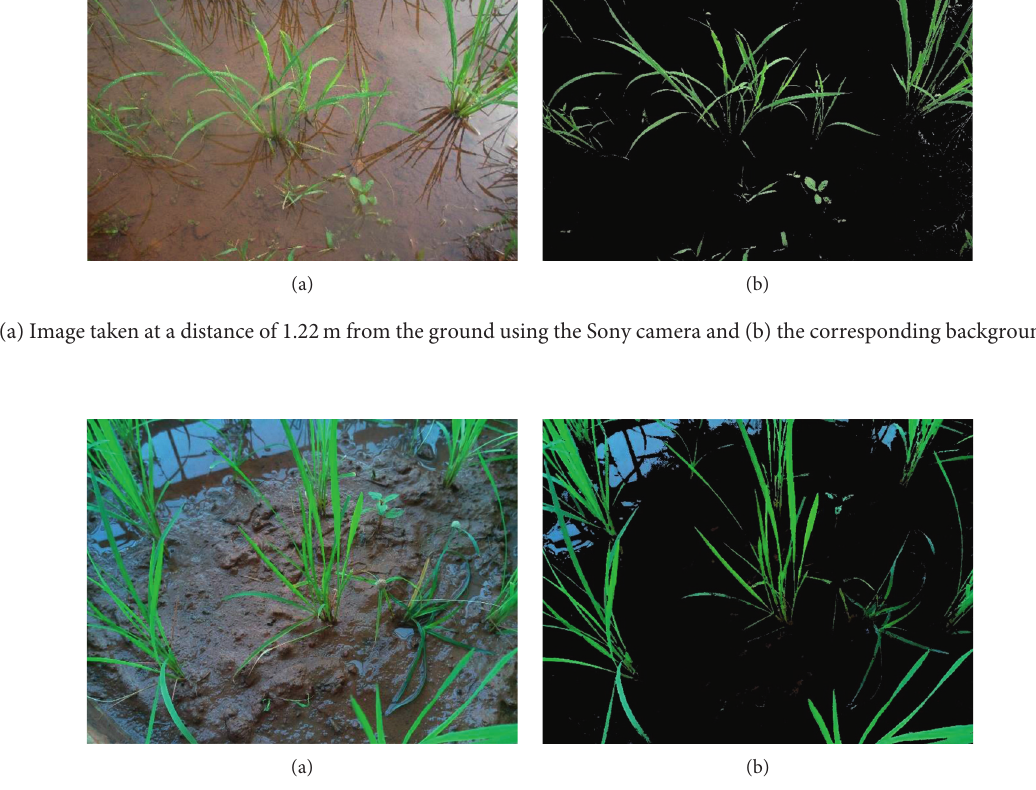
Figure 6: (a) Image acquired by the Raspberry Pi camera and (b) the corresponding background subtracted image.